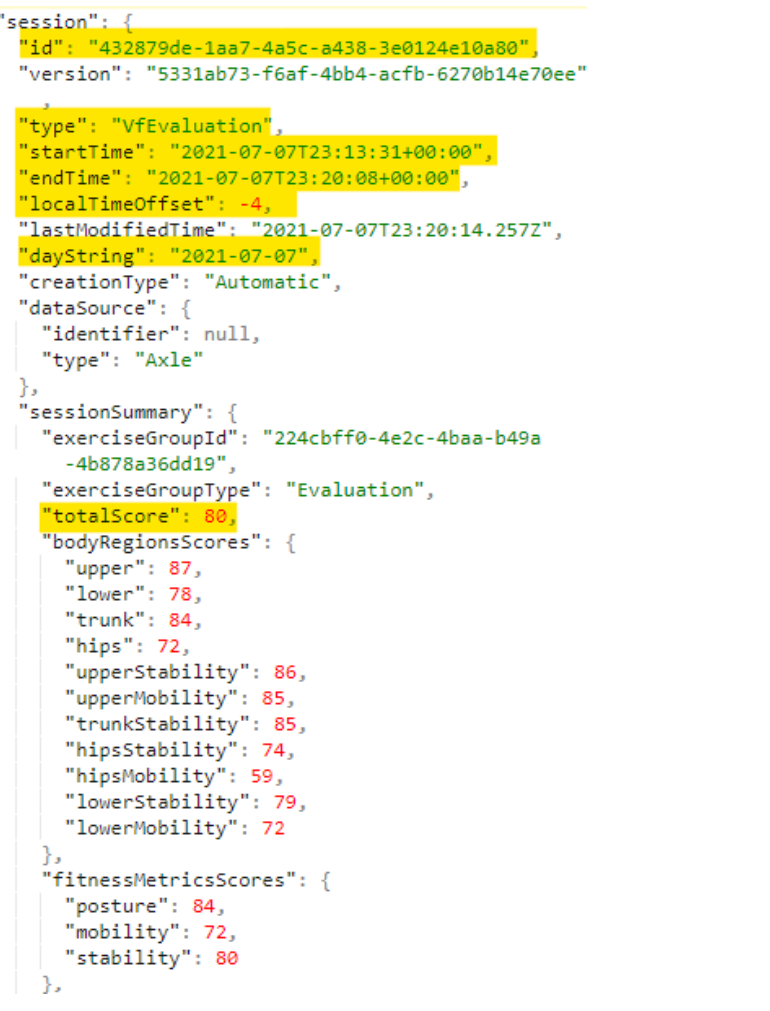
Figure 12. Snippet of the results of the Movement Assessment the Amazon Halo user did.